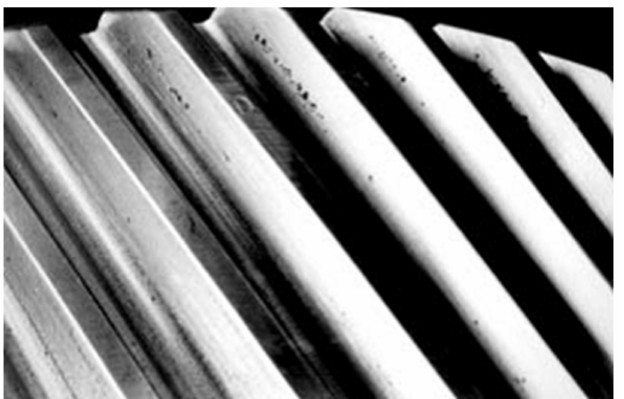
Figure 5. The initial pitting in the connection stage of a pair of teeth—1. Reprinted with permission from ref. [24]. Copyright 2003 Springer